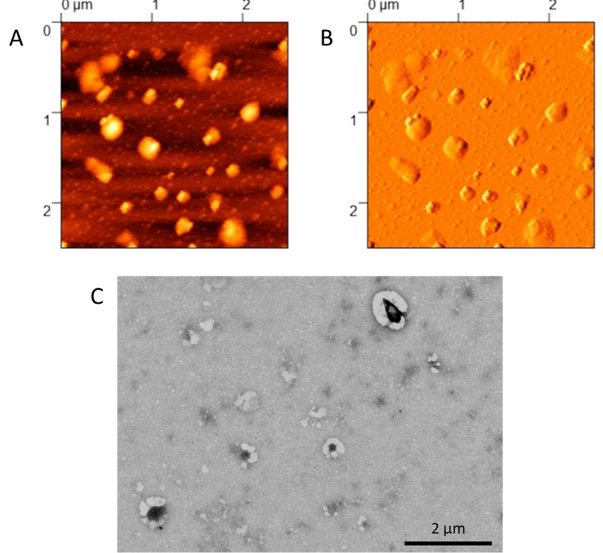
Figure 1. Morphological analysis of HA12-coated NPs, at N:O ratio 1:1. ( A ) AFM “Topography” image, ( B ) AFM “Error Signal” image. ( C ) STEM images. image, ( B ) AFM “Error Signal” image. ( C ) STEM